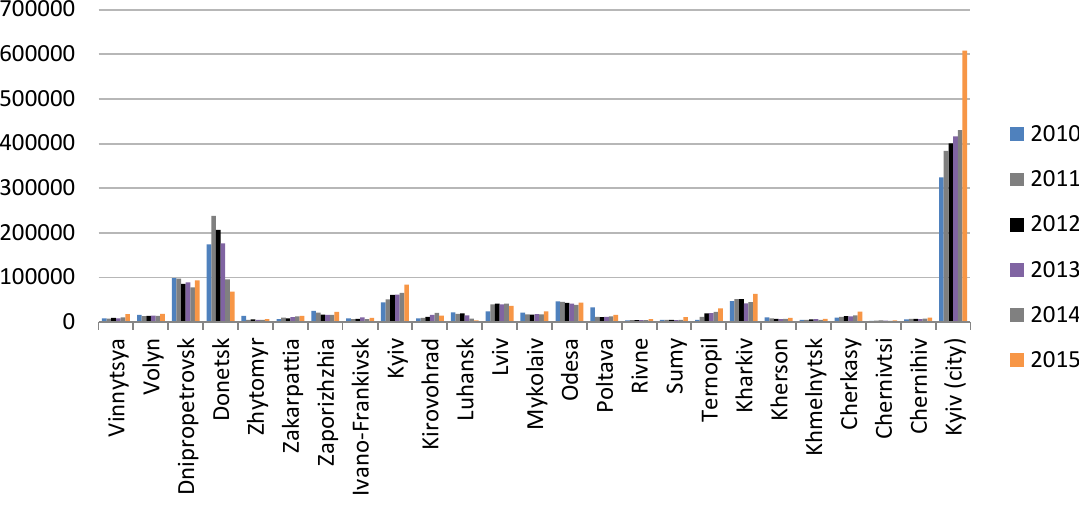
Fig. 7. The wholesale trade turnover by region in 2010 – 2015, million UAH (based on data of the State Statistics Service of